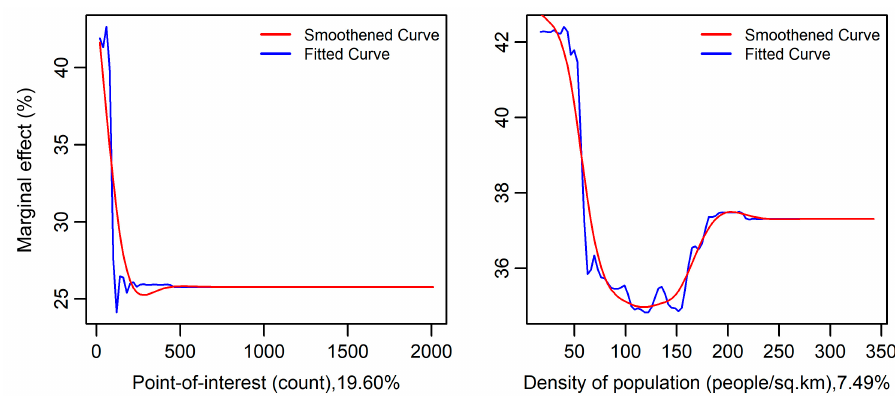
Figure 5. The relationships between socioeconomic resources and RPI.